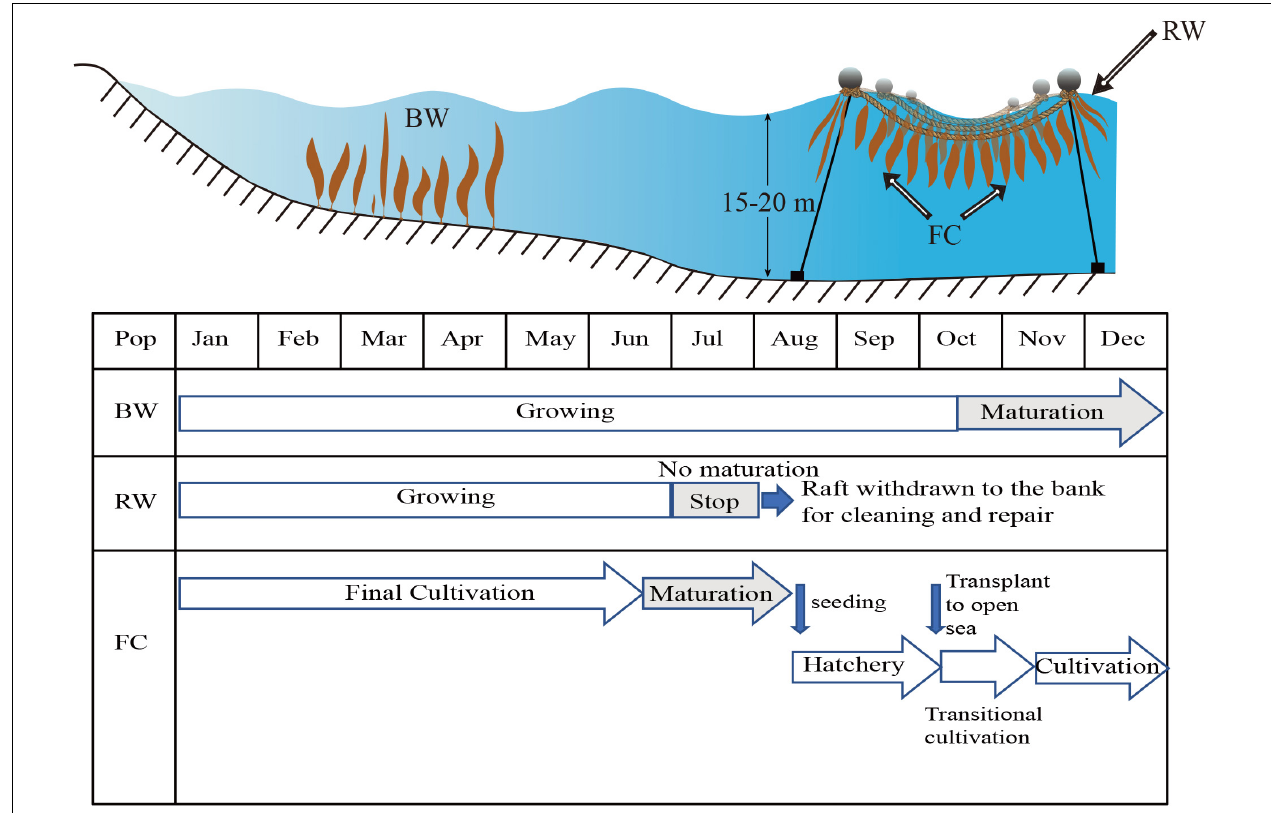
FIGURE 1 | Schematic drawing of the sympatric spontaneous populations in subtidal benthic zone (BW) and on the cultivation rafts (RW), and farmed cultivars (FC) of Saccharina japonica on a typical kelp farm in Dalian China. Their growing and maturation periods are also shown.